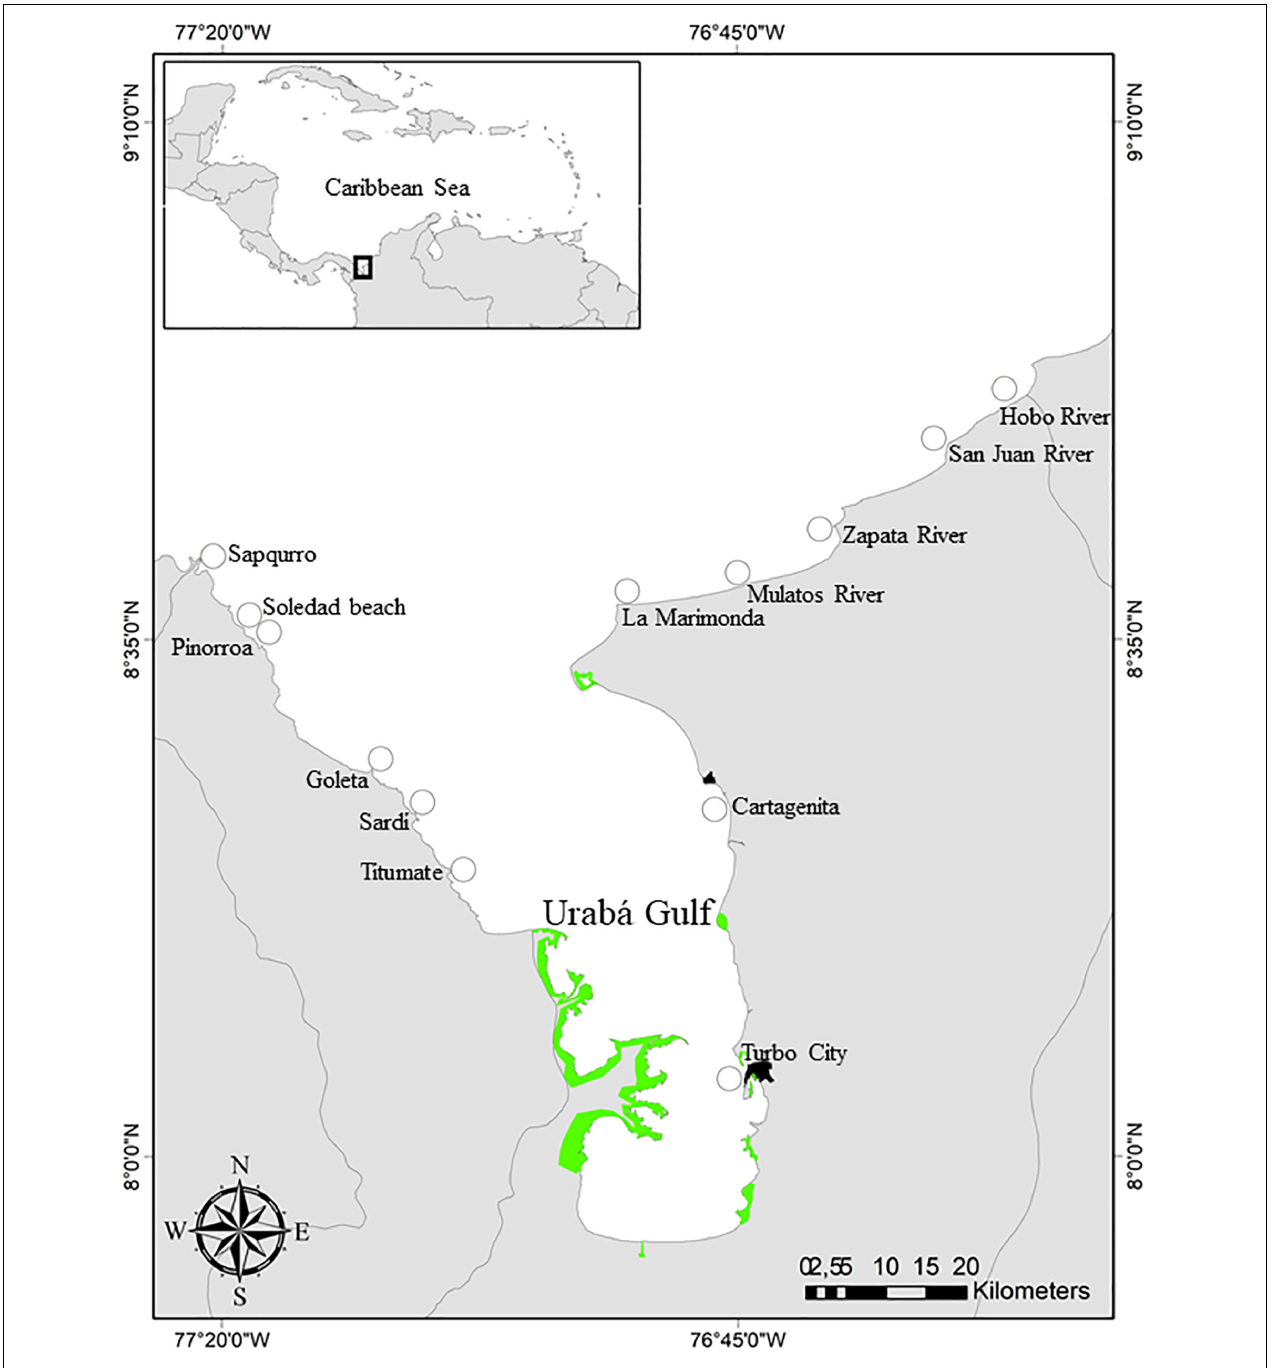
FIGURE 1 | Map of the Urabá Gulf and the sampling sites in the Southern Caribbean of Colombia. The distribution of mangrove areas are shown in green.